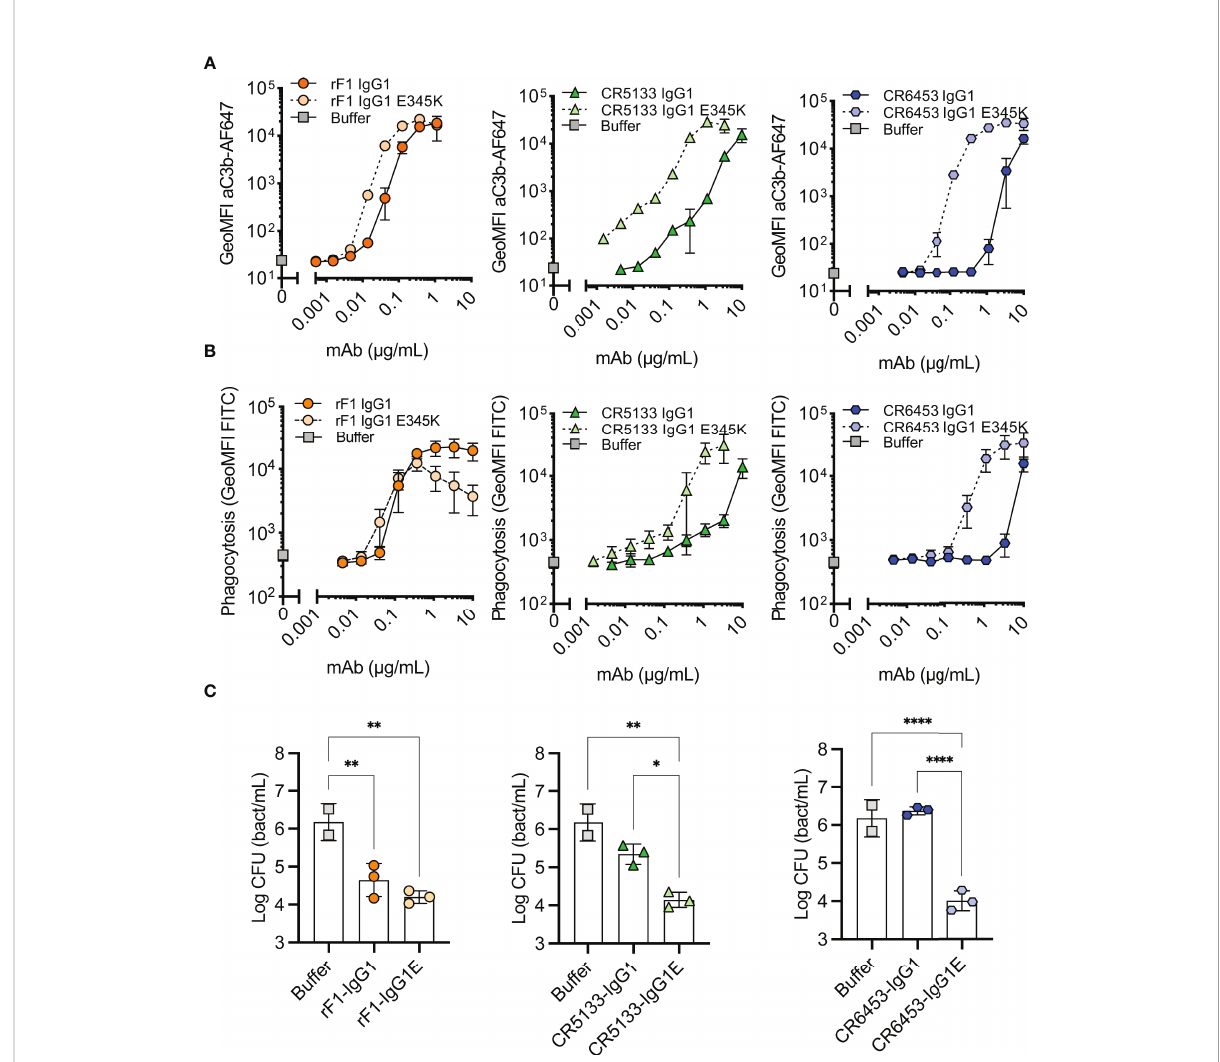
FIGURE 3 Hexamer enhancing mutations signi fi cantly improve effector functions against S. epidermidis. ( A ) Effect of introduced hexamer-enhancing mutations on deposition of C3b. FITC labelled S. epidermidis ATCC 14990 were incubated in 1% D NHS supplemented with a concentration range of mAb in IgG1 or IgG1-E345K variant. C3b deposition was detected by fl ow cytometry using an anti-neoC3b-AF647 antibody conjugate and plotted as AF647 GeoMFI of the FITC+ve bacterial population. Data represent mean ± SD of three independent experiments. (B) Phagocytosis of S. epidermidis ATCC 14990 by neutrophils (MOI 10:1) in the presence of complement. Bacteria were prepared as in (A) . Phagocytosis was assessed by fl ow cytometry and plotted as FITC GeoMFI of the neutrophils population. Data represent mean ± SD of three independent experiments. Data shown for IgG1 are identical to data shown in Figure 2B. (C) Killing of S. epidermidis ATCC 14990 by neutrophils (MOI 1:1) in presence of complement. Bacteria were incubated in 10% D NHS supplemented with 0.148µg/mL (1nM) rF1, 1.48µg/mL (10nM) CR5133 or CR6453. All concentrations tested can be viewed in Figure S5. Bacterial survival was quanti fi ed after neutrophils lysis by serial